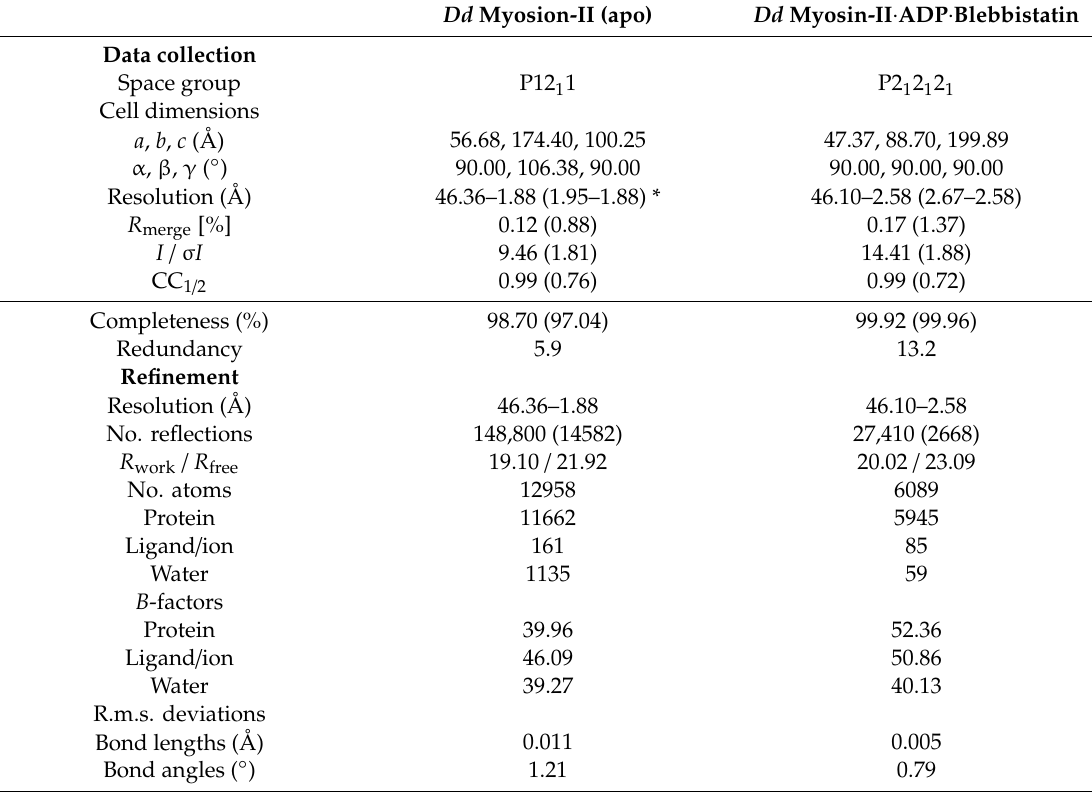
Table 1. Data collection and refinement